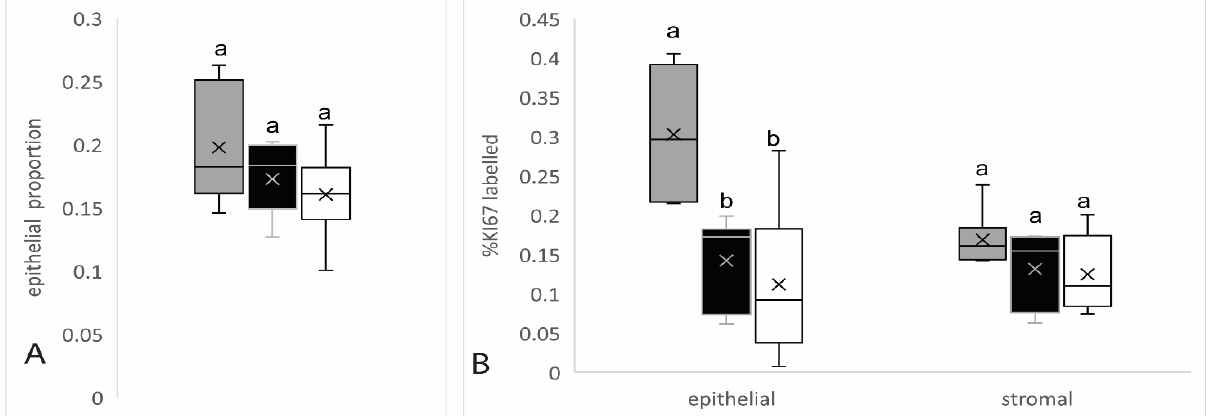
Figure 3. Tissues immunostained for KI67 (brown) and counterstained with hematoxylin. ( A ) Jejunum was collected from gilts and used as a positive control for KI67 labeling of proliferating cell populations in tissues. Arrow indicates crypt region of villi. Immunostaining of KI67 shows that epithelial cells within the crypt region of the villi were immunostained, whereas those lining the villi of the jejunum were mostly lacking positive cells. ( B ) Negative control mammary tissue was incubated with rabbit IgG rather than primary antibody and show a lack of brown nuclei. Mammary tissue from ( C ) COL10 and ( D ) COL20 gilts immunostained with KI67 have positively stained cells in the epithelial and stromal compo- nents of the parenchymal compartment. Images were captured at 200×.